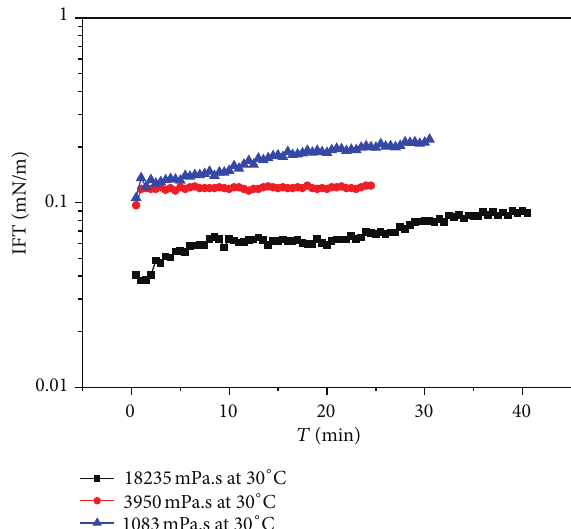
Figure 12: Dynamic IFT curves of Xia-8 heavy oil/0.5% NaOH + 0.5%